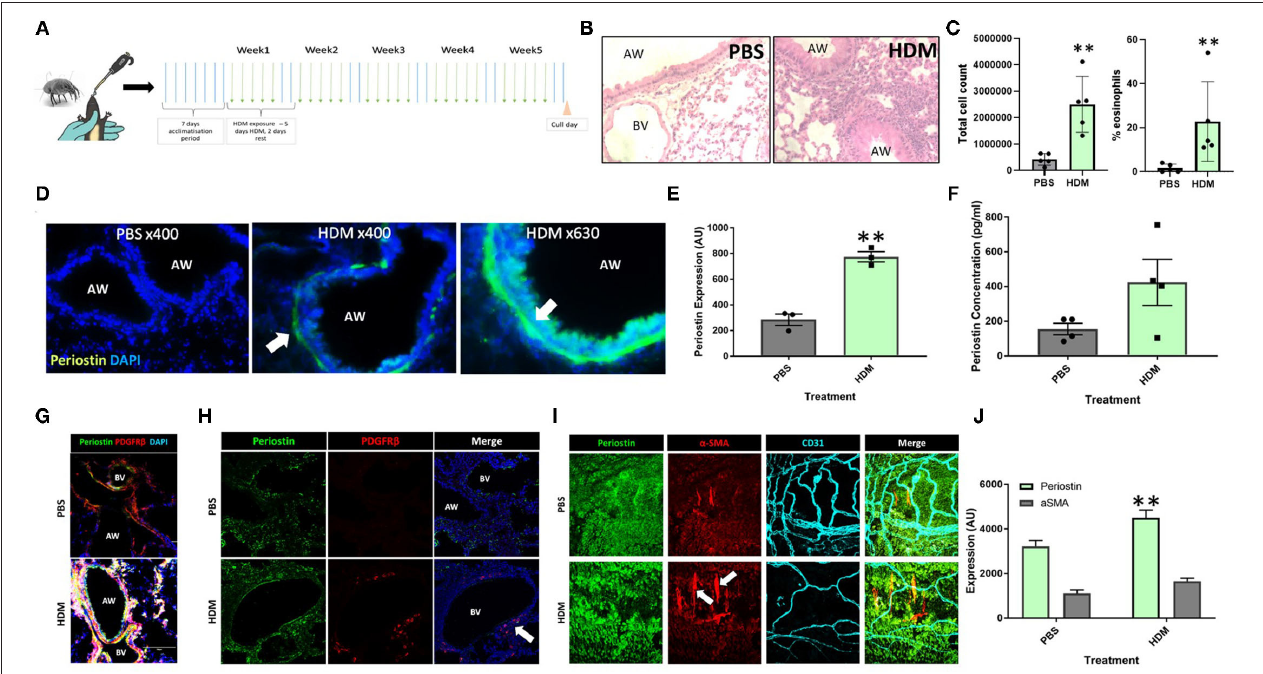
FIGURE 1 | Periostin expression is increased following chronic aeroallergen exposure in mice. (A) Schematic diagram of HDM-induced allergic airway inflammation in mice. (B) Female C57/Bl6 mice (6–8 weeks old) were exposed to either sterile PBS (10 µ l intranasally) or house dust mite extract (HDM; 25 µ g in 10 µ L) 5 days a week for five consecutive weeks. Hematoxylin and eosin stained lung sections from PBS and HDM-exposed mice. (C) Bronchoalveolar lavage fluid total cell counts and percentage of eosinophils. (D) At the end of the allergen exposure protocol, lung sections obtained from PBS control and HDM-exposed mice were stained with an anti-periostin antibody (green) and DAPI to stain nuclei (blue). Images were taken at 400x and 630x magnification as stated. Arrows indicate periostin positive cells. (E) Expression of periostin was calculated in the area of interest around each airway using ImageJ. ** p < 0.01, n = 3 representative of two independent experiments. (F) Bronchoalveolar lavage samples were collected and the periostin content was assessed by ELISA. n = 4 representative of two independent experiments. (G,H) Lung sections were stained for periostin (green), the pericyte marker PDGFR β (red), and cell nuclei (DAPI, blue) to demonstrate the presence of periostin-expressing pericytes around the airways and blood vessels of HDM-exposed mice. (I) Tracheobronchial whole mounts were stained for the mesenchymal cell marker α -smooth muscle actin ( α -SMA; red), the endothelial cell marker CD31 (cyan), and periostin (green) and imaged at 400x magnification; arrow indicate periostin-positive pericytes. (J) The expression of periostin and α -SMA in tracheobronchial whole mounts was calculated using ImageJ. AW, airway; BV, blood vessel. ** p < 0.01, n = 3–5 representative of two independent